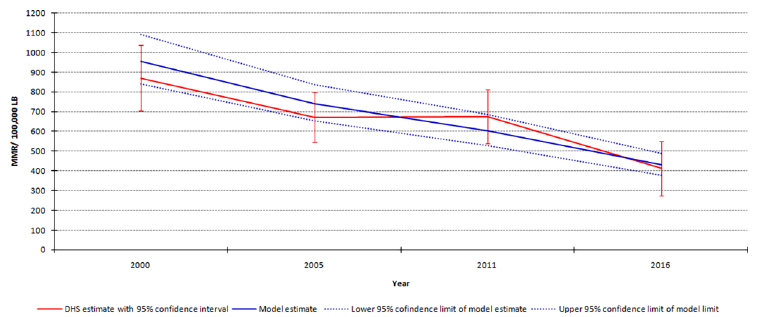
Fig 5. MMR in Ethiopia between 2000–1016 based on DHSs and the model